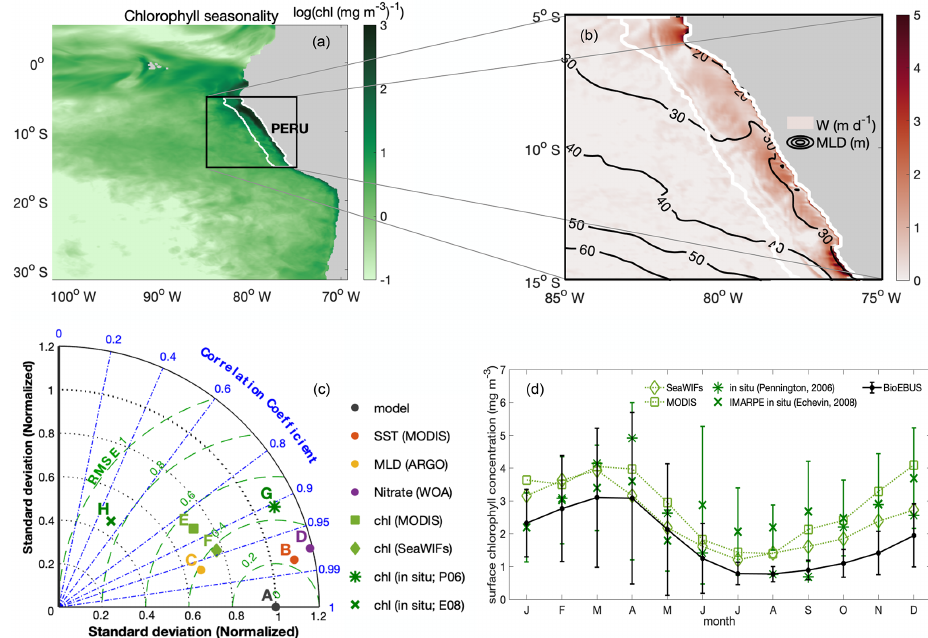
Figure 1. (a) Spatial distribution of the amplitude of the annual cycle of surface chlorophyll in log scale (log ( chl ( mgm − 3 ) − 1 )); (b) map of annual mean upwelling velocity w (md − 1 ) at the bottom of the mixed layer, with contour lines indicating MLD (m). White lines highlight the focus area. (c) Taylor diagram for seasonal SST (red), MLD (yellow), surface nitrate (purple) and chlorophyll (green) concentrations. The black dot indicates the model simulation as a reference. The radial distance from the origin is proportional to the standard deviation, normalized by the standard deviation of the data. The dashed green lines show the RMSE. The correlations between model and observations are given by the azimuthal position. (d) Seasonal cycles of surface chlorophyll concentration from model simulation (solid black line), satellite data (dotted line; SeaWIFS (diamond) and MODIS (square)), and in situ data digitized from Pennington et al. (2006) (star; 250km band off the coast) and Echevin et al. (2008) (cross). Error bars indicate the standard